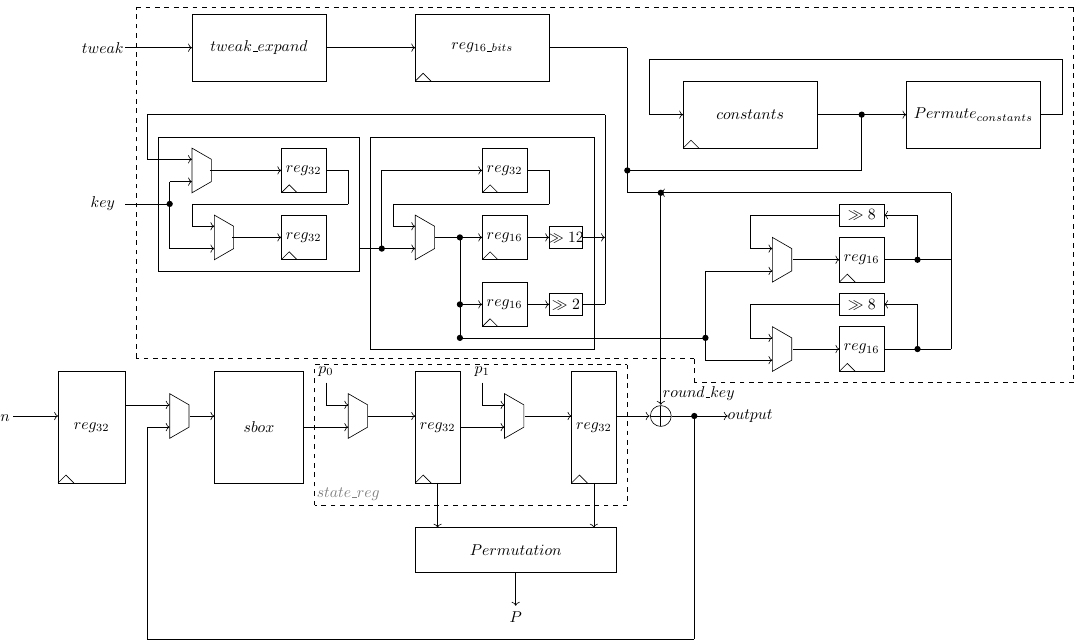
Figure 6. tweGift-64 design implementation, for a 32-bit